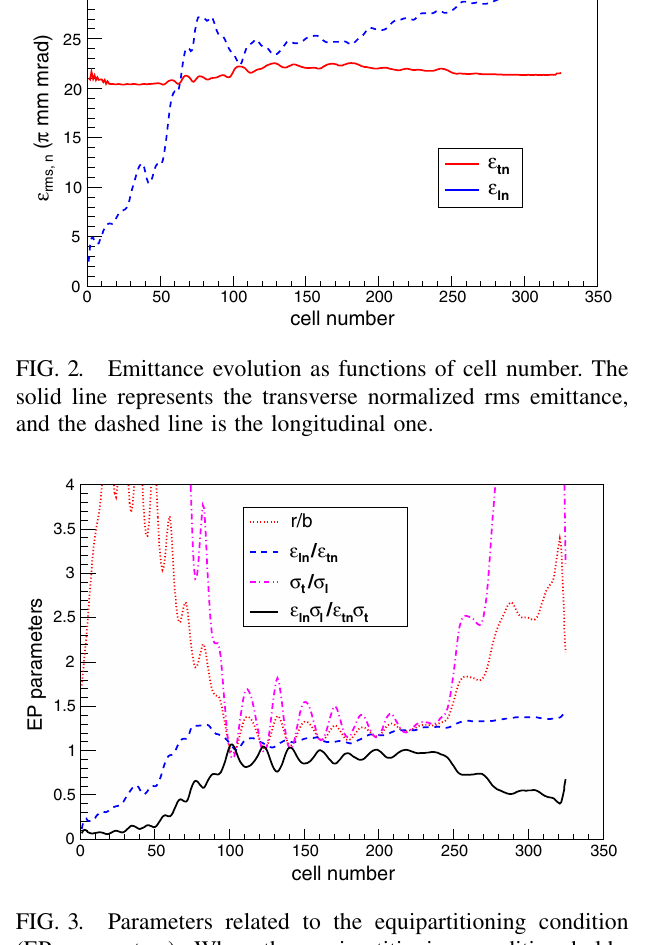
FIG. 3. Parameters related to the equipartitioning condition (EP parameters). When the equipartitioning condition holds, the solid line should be one.